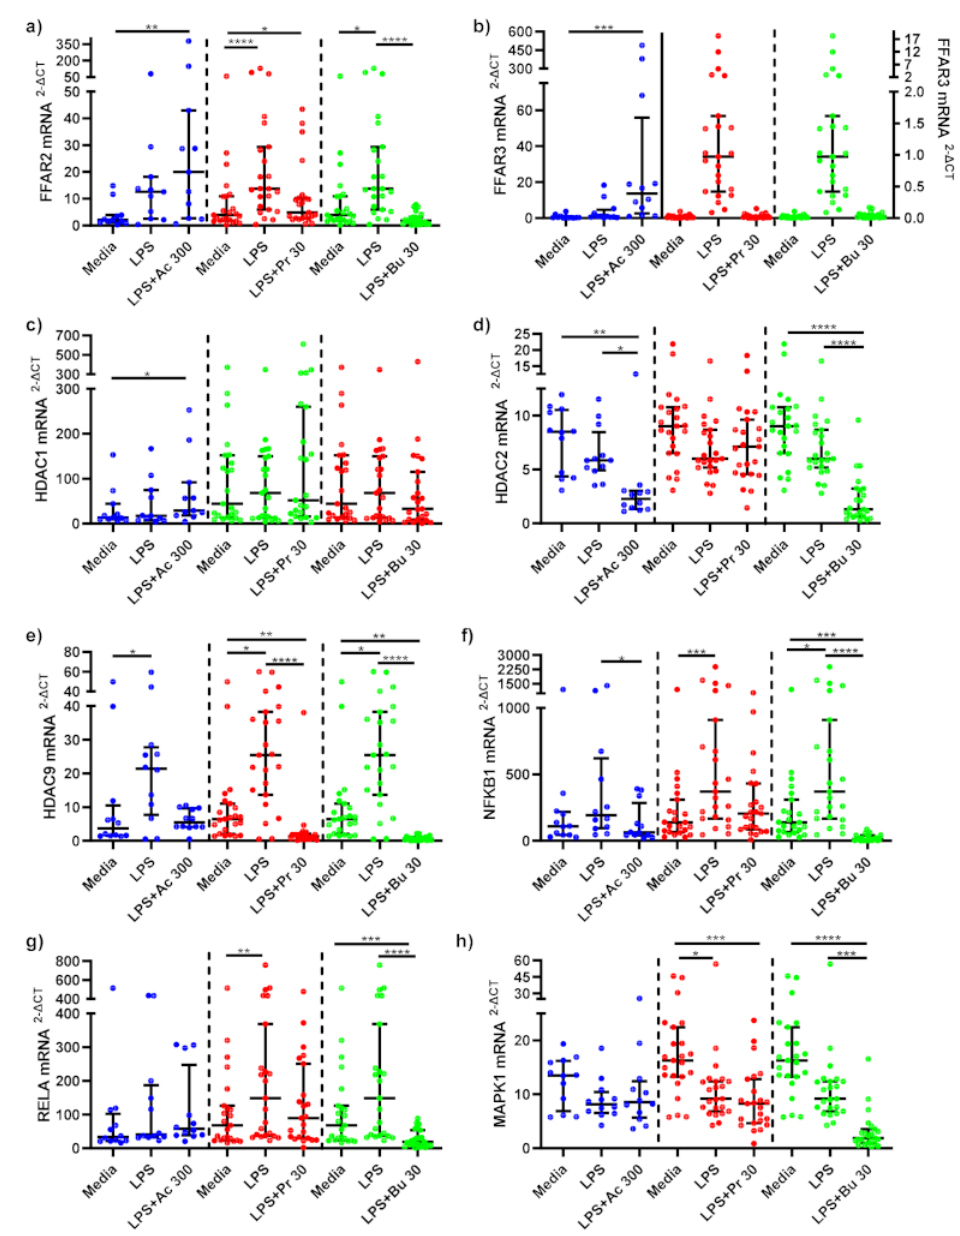
Figure 4. mRNA expression response of LPS-stimulated monocytes following short-chain fatty acid treatments. mRNA expression of ( a ) FFAR2, ( b ) FFAR3 (sodium acetate [left Y axis], sodium propionate [right Y axis] and sodium butyrate [right Y axis]), ( c ) HDAC1, ( d ) HDAC2, ( e ) HDAC9, ( f ) NFKB1, ( g ) RELA, and ( h ) MAPK1 produced by monocytes stimulated with LPS (1 ng/mL) alone or treated simultaneously with sodium acetate ( n = 13) 300 mM or sodium propionate ( n = 24) 30 mM or sodium butyrate ( n = 25) 30 mM following 15 h incubation. Parametric data analysed by RM one-way ANOVA and post hoc analysis Tukey’s multiple comparison test, non-parametric by the Friedman test and post hoc analysis by Dunn’s multiple comparisons test. LPS; lipopolysaccharide, Ac; acetate, Pr; propionate, Bu; butyrate. * p < 0.05, ** p < 0.01, *** p < 0.001 and **** p < 0.0001. Data expressed as the mean